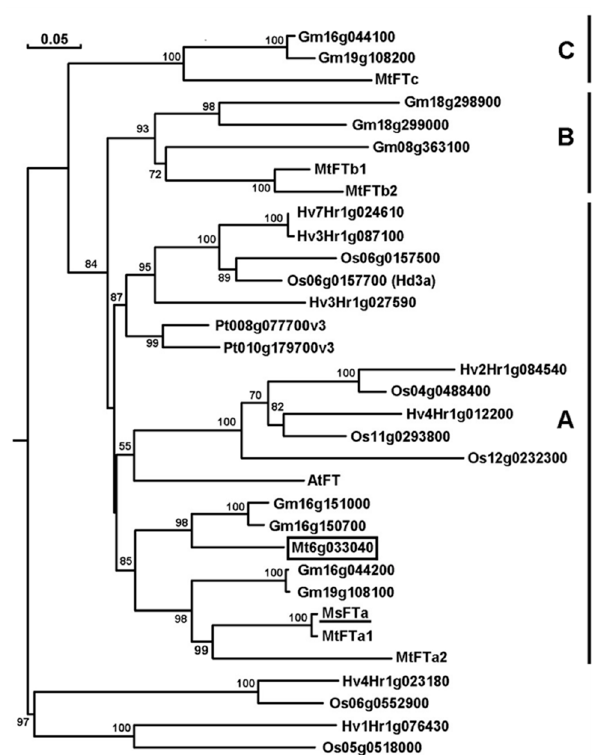
Figure 1. Phylogenetic analysis of MsFTa and its orthologs in the indicated plant species. The full-length sequence of 33 FT and FT-like proteins from six model species was analyzed using DNAMAN (version 7.0). The numbers at the nodes of the neighbor-joining tree indicate the bootstrapping values based on 1000 interactions. MsFTa was underlined and Mt6g033440, a novel FT in M. truncatula was